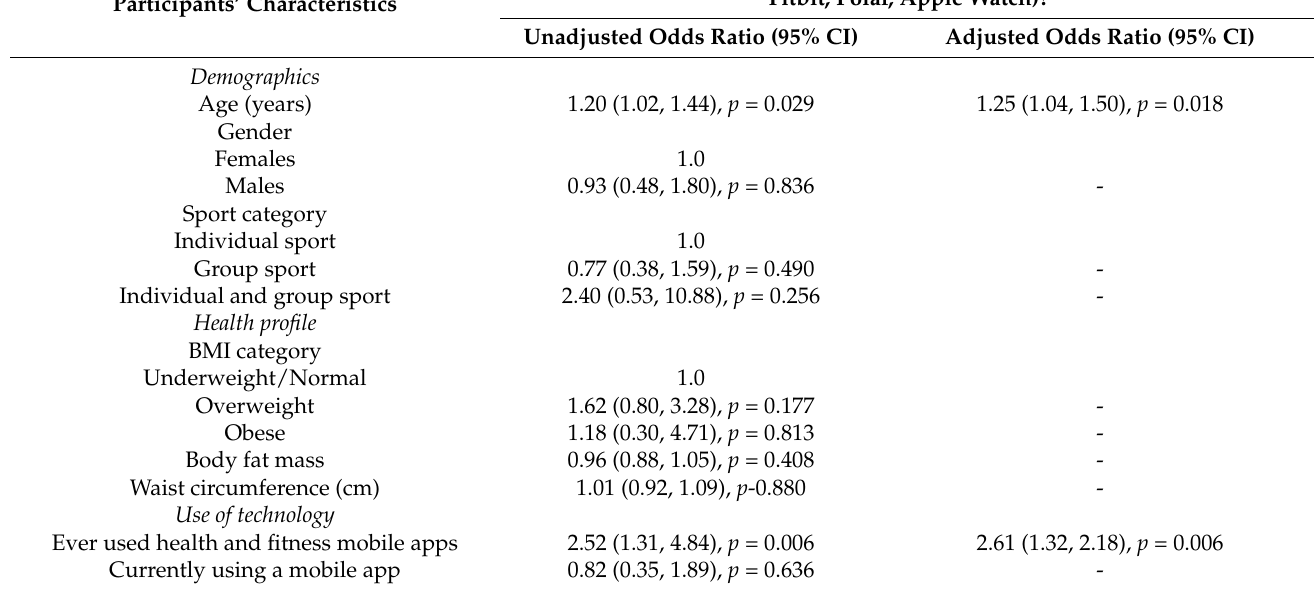
Table 5. Associations of socio-demographic, health characteristics and technology use with the use of health and fitness tracking devices. Have You Ever Owned a Fitness Tracker to Track Your Activity or Diet (e.g., Fitbit, Polar, Apple Participants’ Characteristics